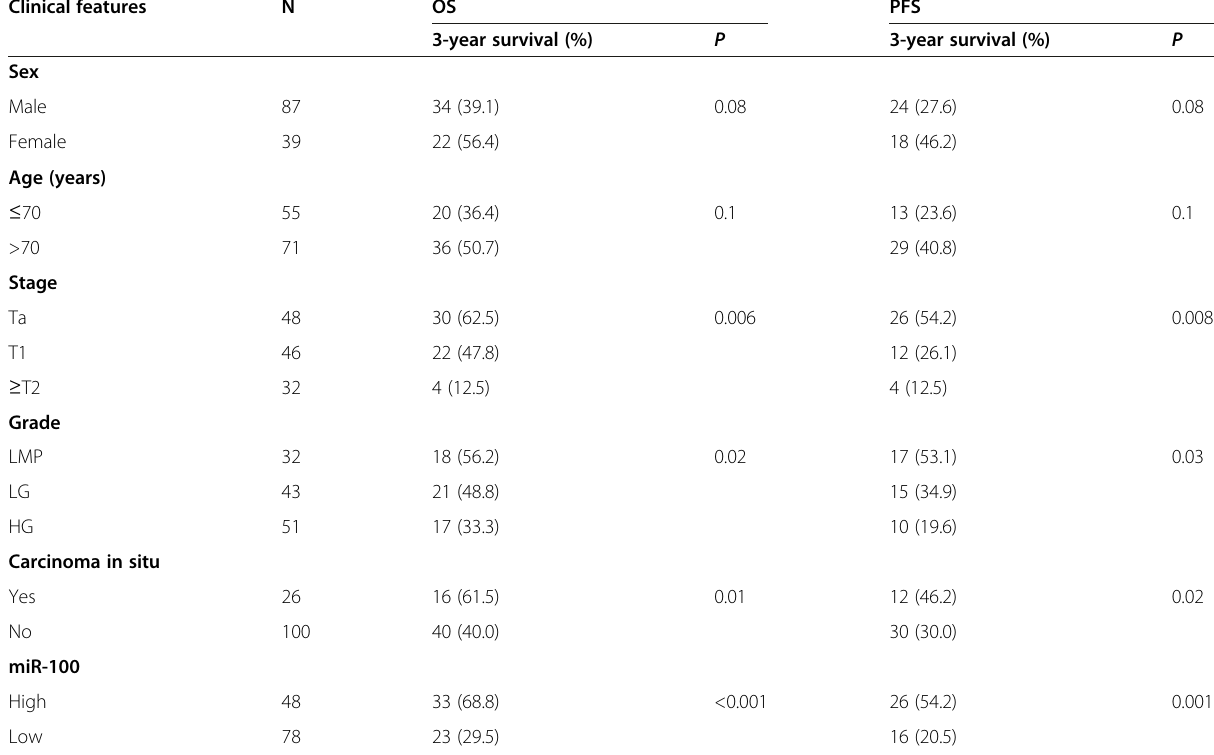
Table 3 Univariate analyses of various clinicopathological parameters in relation to survival of patients with bladder cancer Clinical